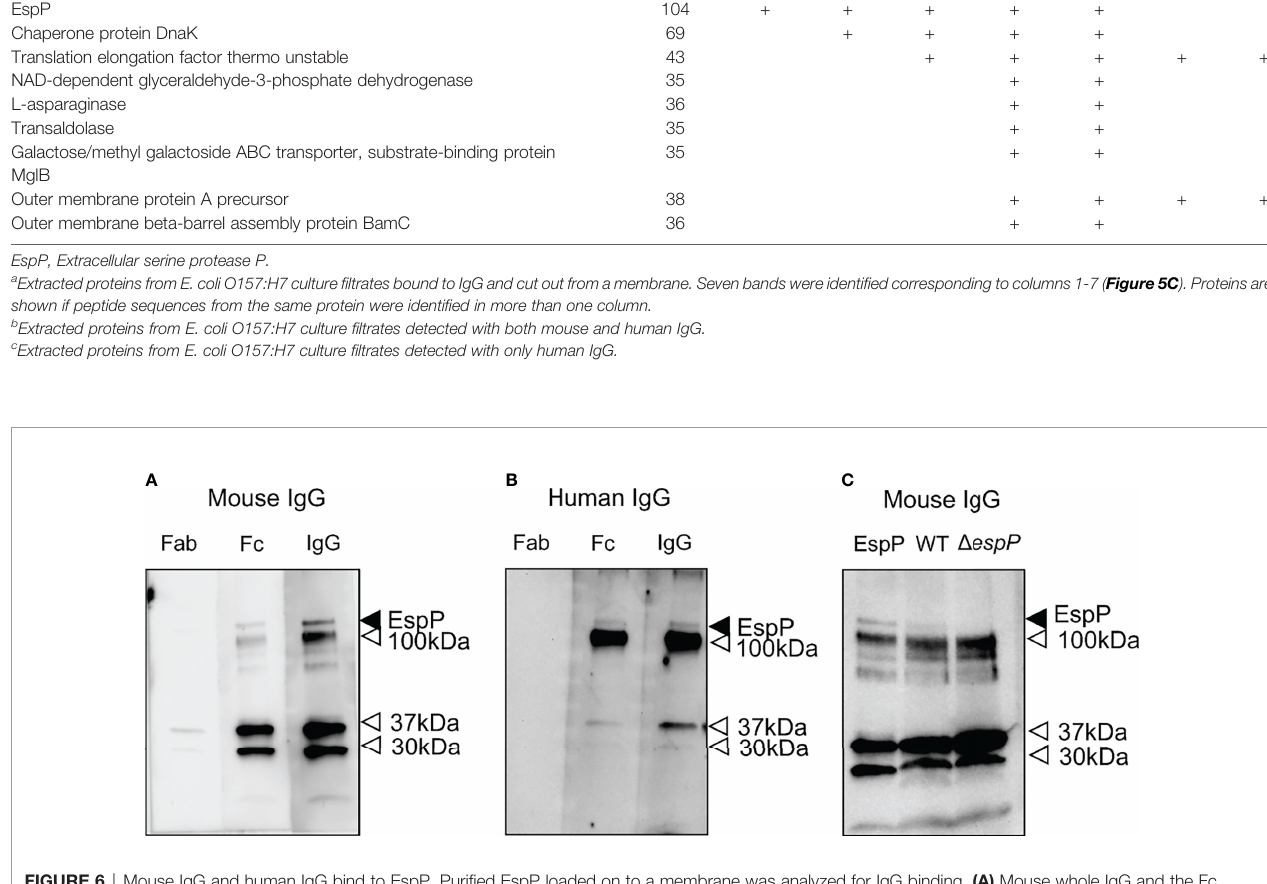
FIGURE 6 | Mouse IgG and human IgG bind to EspP. Puri fi ed EspP loaded on to a membrane was analyzed for IgG binding. (A) Mouse whole IgG and the Fc fragment, but not the Fab fragment, bound to EspP. All lanes were run on the same gel. (B) Human whole IgG and the Fc fragment, but not the Fab fragment, bound to EspP. All lanes were run on the same gel. (C) Detection of EspP in culture fi ltrate from wild-type E. coli O157:H7 but not in the D espP strain run alongside puri fi ed EspP bound to mouse IgG. Full-length EspP detected at 104 kDa with mouse or human IgG, marked with a black arrowhead. Bands detected at different molecular weights than the full-length EspP marked with an open arrowhead representing proteins other than EspP that bind IgG.